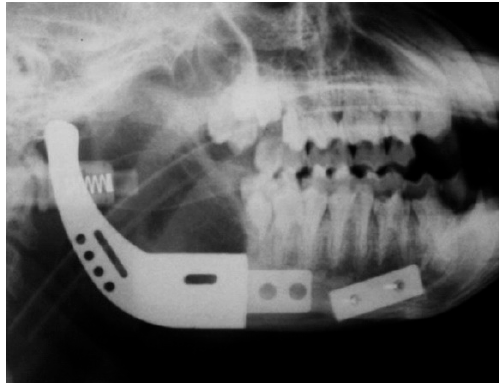
Figure 1. Lateral mandibular radiograph of modular endoprosthesis attached to the mandible. Reproduced with permission from [56], Elsevier, 2019.